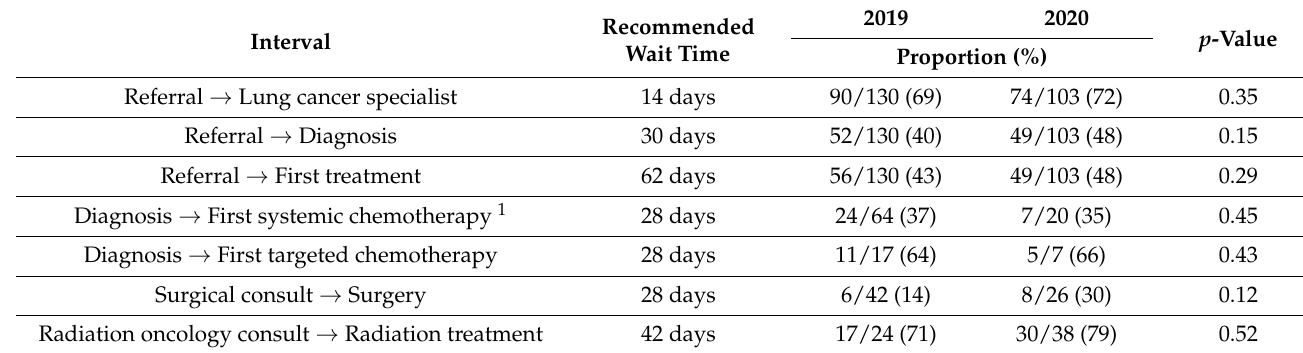
Table 5. Meeting the wait time standards.